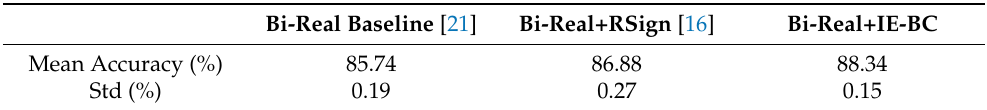
Table 1. Comparison of the different methods that use modified sign function on the baseline model. We run each model three times and report the mean accuracy and standard deviation on the CIFAR-10 test dataset.